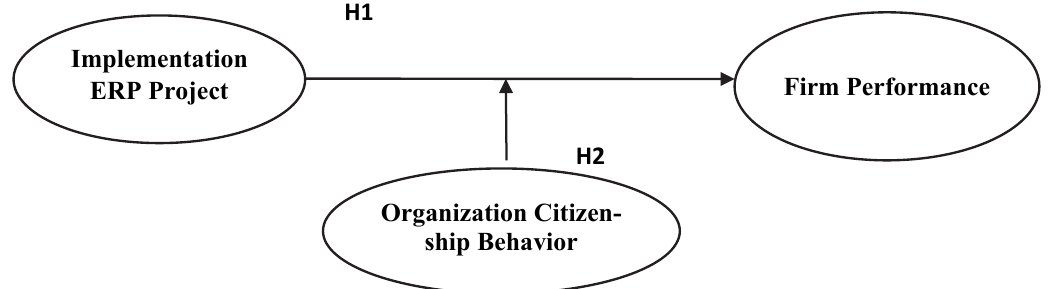
Fig. 2. ERP Project Implementation Model for Firm